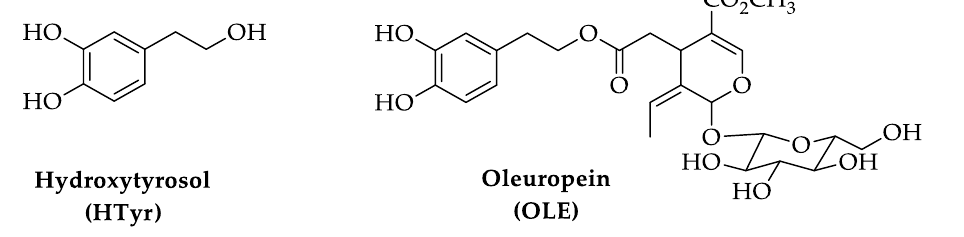
Figure 2. Hydroxytyrosol (HTyr) and oleuropein (OLE). OLE is a secoiridoid found in many plants. In the Oleacea family, its content is high in leaves and green olives (26.5 and 19.2 mg/Kg, respectively). During fruit ripening, the content of OLE decreases being hydrolyzed by endogenous α -glycosidases producing glucose, oleuropein aglycone, HTyr and elenolic acid (Scheme 1). A similar process occurs during EVOO production [40].